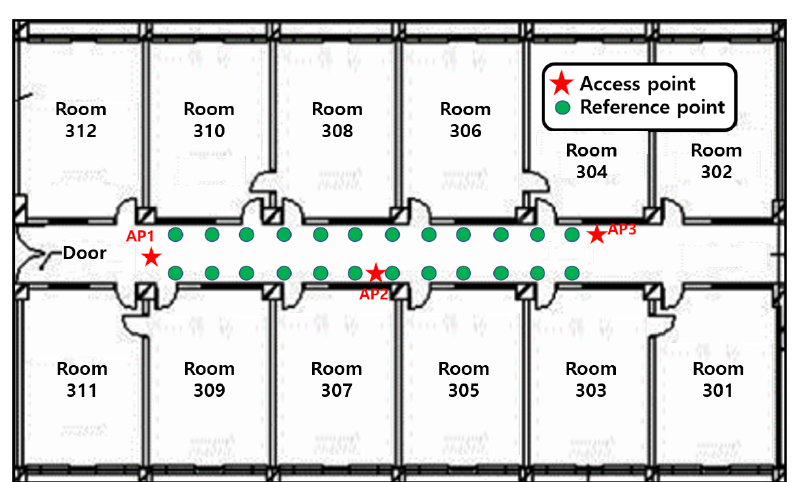
Figure 20. Floor plan of the corridor on the 3rd floor of KNU IT-1 building.